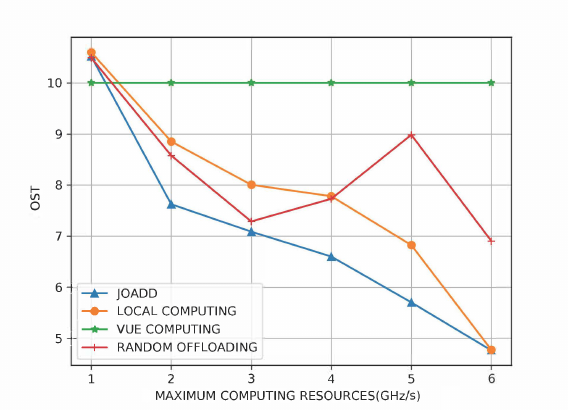
Figure 8. The effect on cost of the different maximum computational resources of the MEC server.